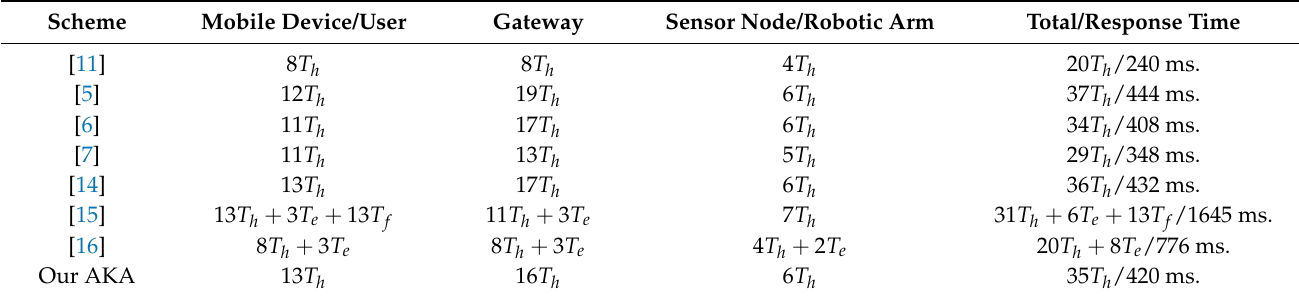
Table 4. Computation cost